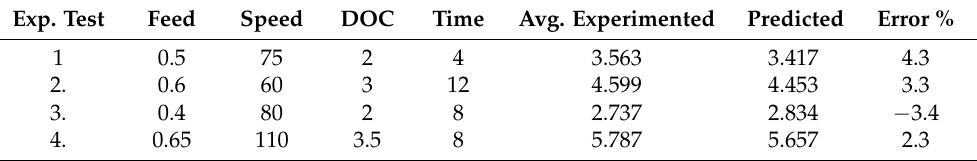
Table 8. Confirmation test results for surface